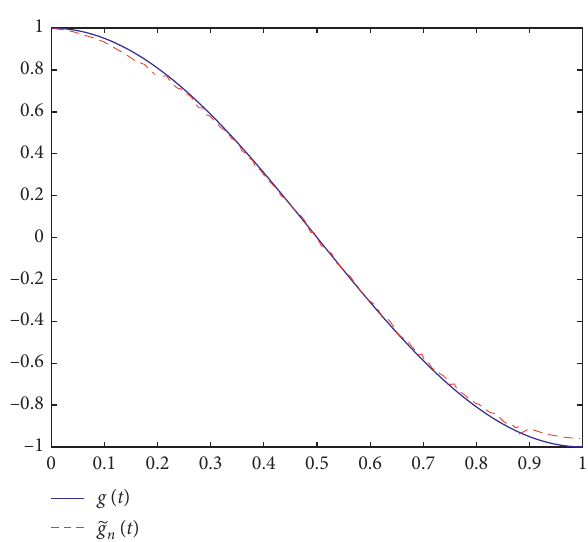
Figure 3: Curves of g ( t ) � cos ( π t ) and 􏽢 g n � 1500.